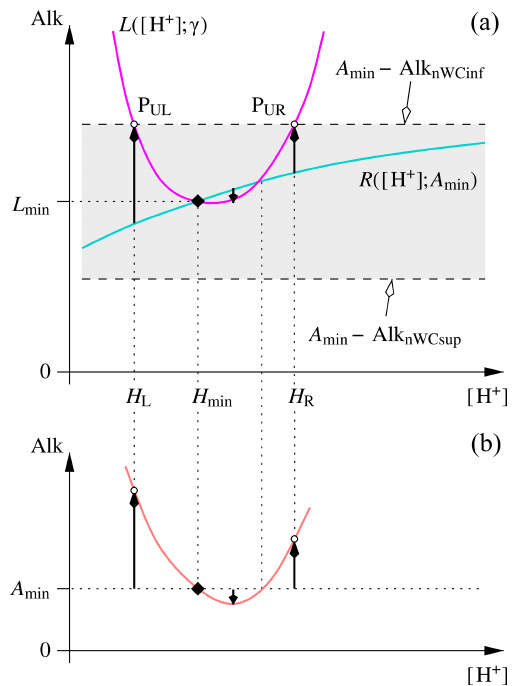
Figure 3. Determination of the A value for which the L( [ H + ]; γ) and R( [ H + ]; A) curves become tangent, or, equivalently, the lowest Alk T value for which the equation L( [ H + ]; γ) − R( [ H + ]; Alk T ) = 0 has a solution. Panel (a) shows how relevant characteristic points can be derived by considering the particular R( [ H + ]; A) curve that intersects L( [ H + ]; γ) at its minimum. Panel (b) shows the locus of the solutions of L( [ H + ]; γ) − R( [ H + ]; Alk T ) = 0 in an [ H + ]− Alk T ) graph, i.e. the curve Alk T ) = L( [ H + ]; γ) + Alk ncW ( [ H + ] ) . Please notice that A min = L min + Alk ncW (H min ) denotes the alka- linity value obtained for [ H + ] = H min , and not the minimum value of the curve shown in panel (b) . See text for